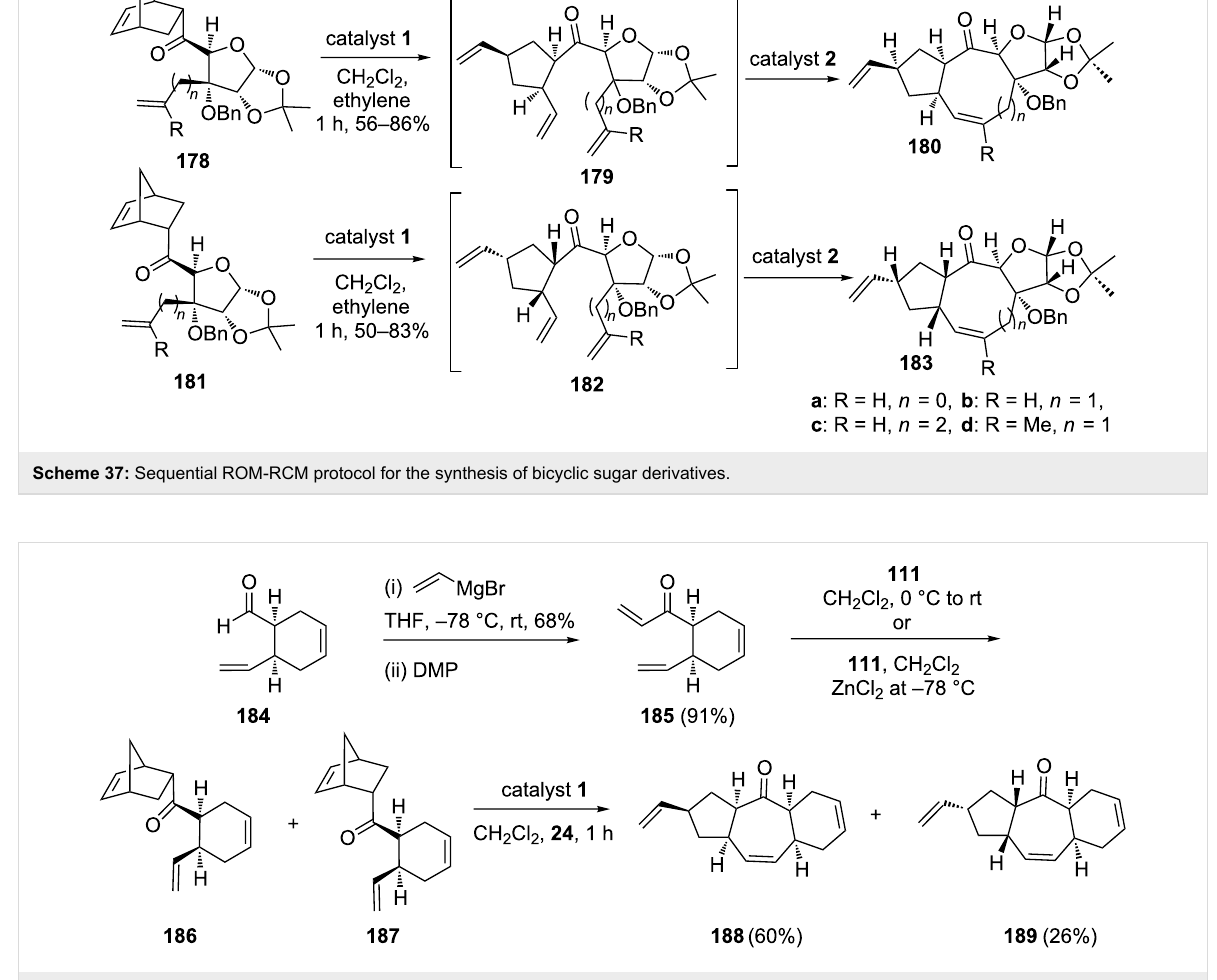
Scheme 38: ROM–RCM sequence of the norbornene derivatives 186 and 187